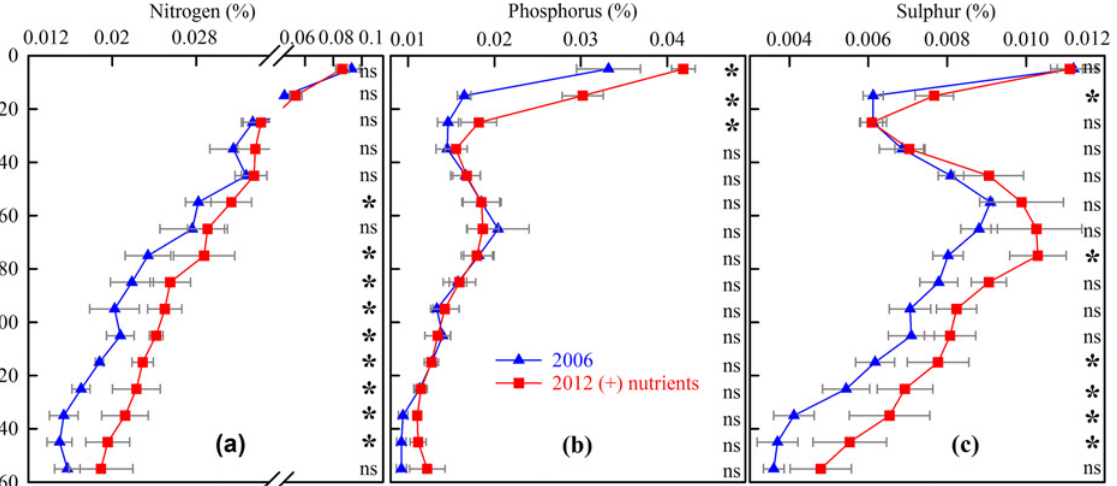
Fig 3. Mean FF-N, -P, -S concentrations (%) to 1.6 m depth in the < 2 mm soil fraction in 2006 and the (+) nutrient treatment in 2012. Data are means and SEM, n = 4 . ( * indicate a significant difference between 2006 value and 2012 value from (+) nutrient treatment P < 0.05; ns = not significant)